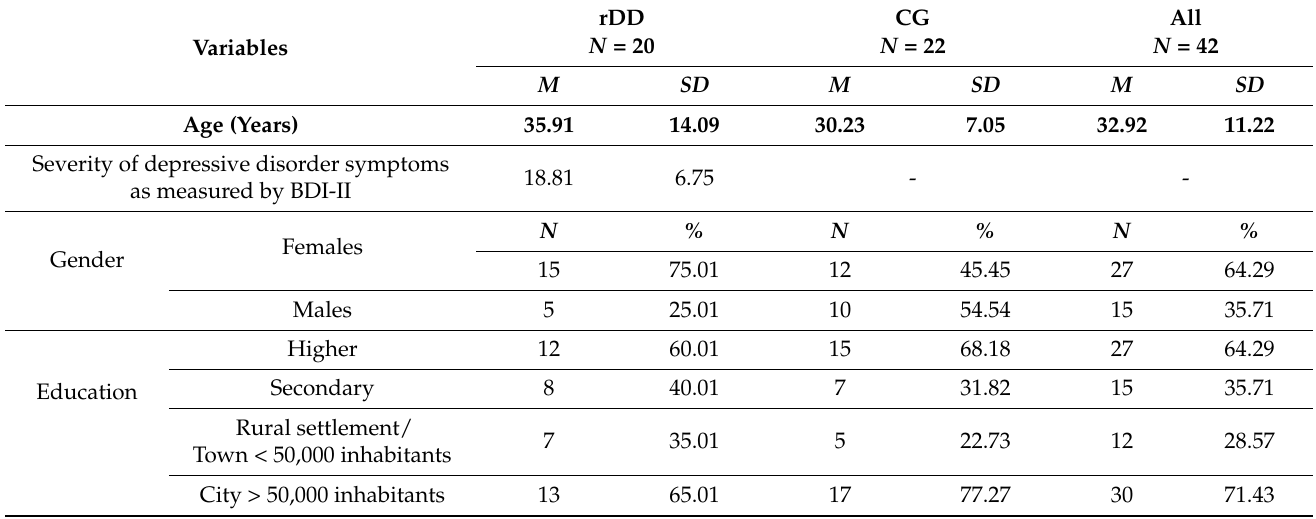
Table 1. The social and demographic characteristics of the study